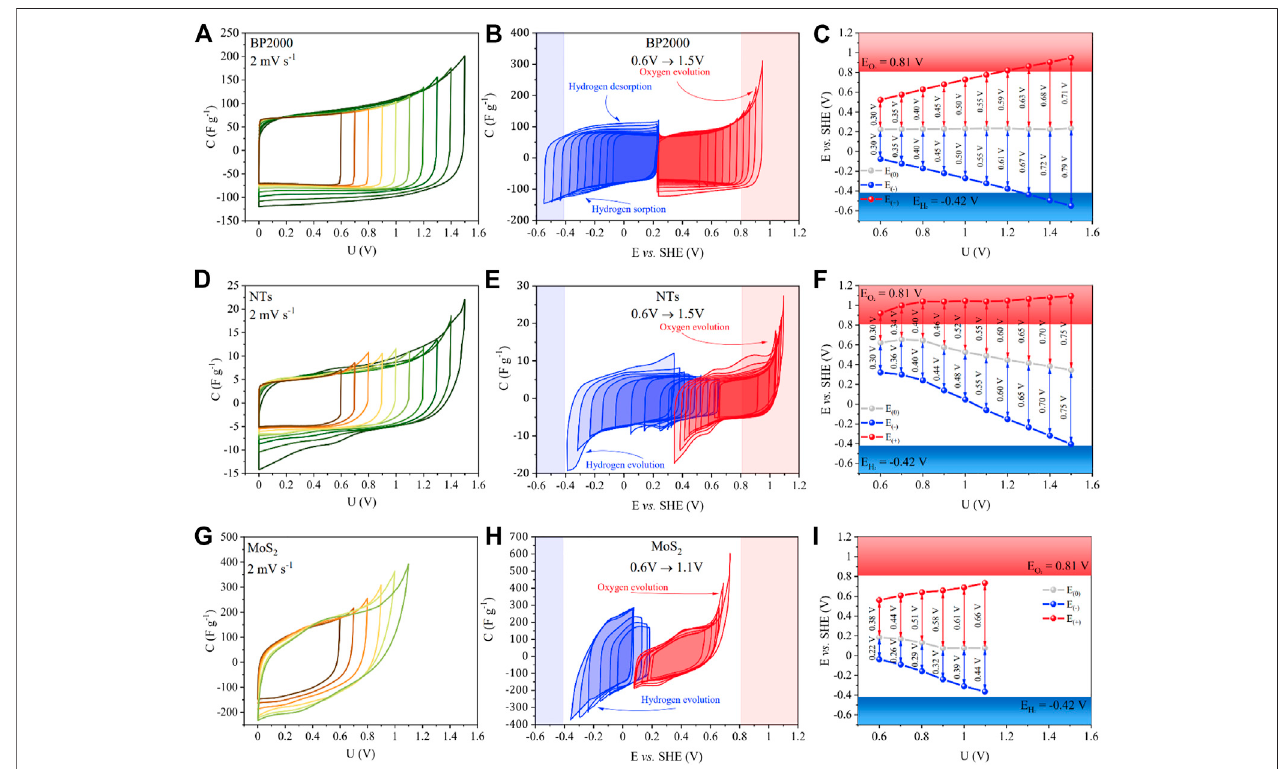
FIGURE 8 | Electrochemical characterization of symmetric EC cells. Cyclic voltammograms of gradual voltage extensions for BP2000, NTs, and MoS 2 — (A), (D), and (G) . Individual cyclic voltammograms for (+) and ( − ) electrodes — (B), (E), and (H) . Operational potentials for both electrodes at each voltage — (C), (F), and (I).